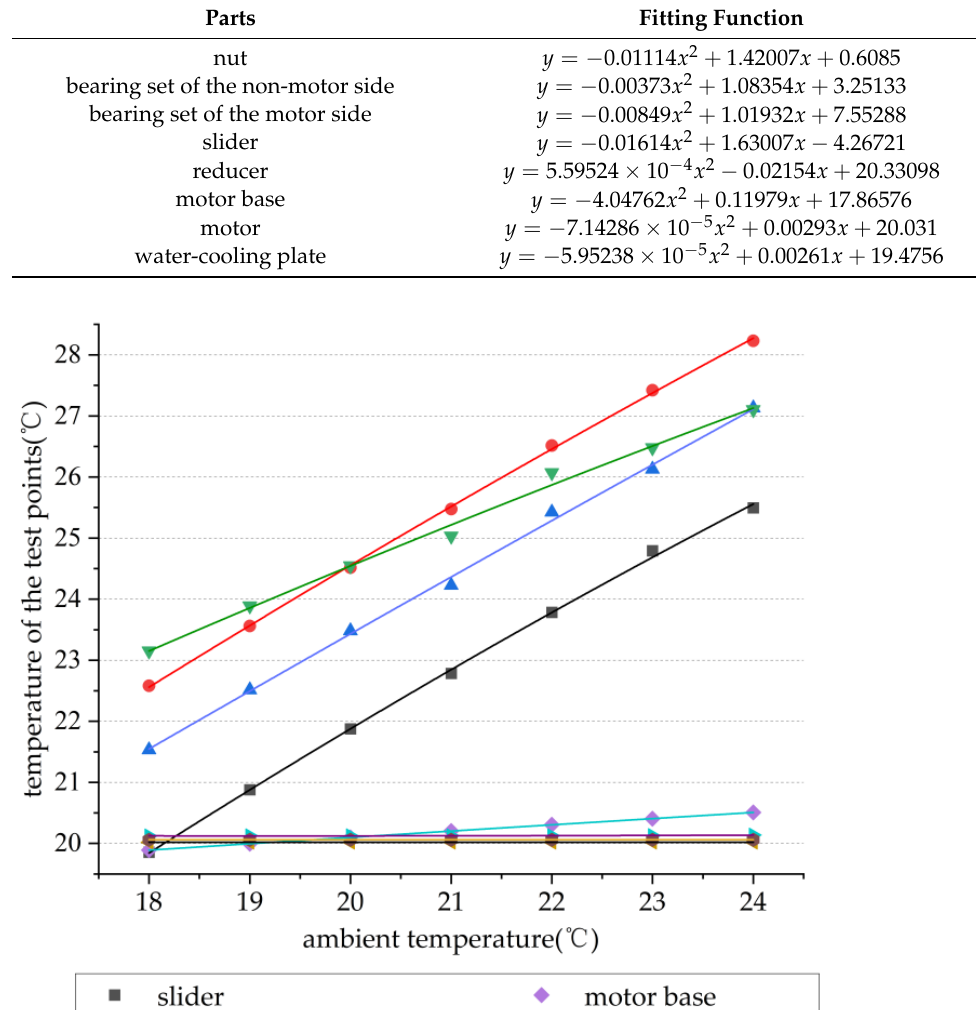
Table 10. Fitting function of temperature measurement points of each component under different ambient temperatures.